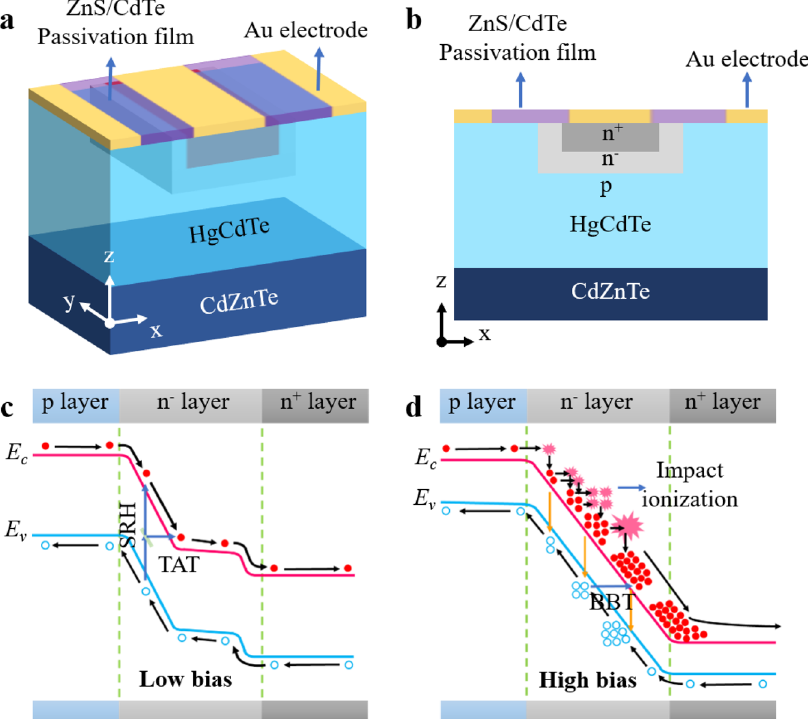
Fig. 1 Schematic of the avalanche photodetector and energy band structure. a Three-dimensional view and b cross-section view of the HgCdTe photodetector. The band structures at c low bias and d high reverse bias are shown,